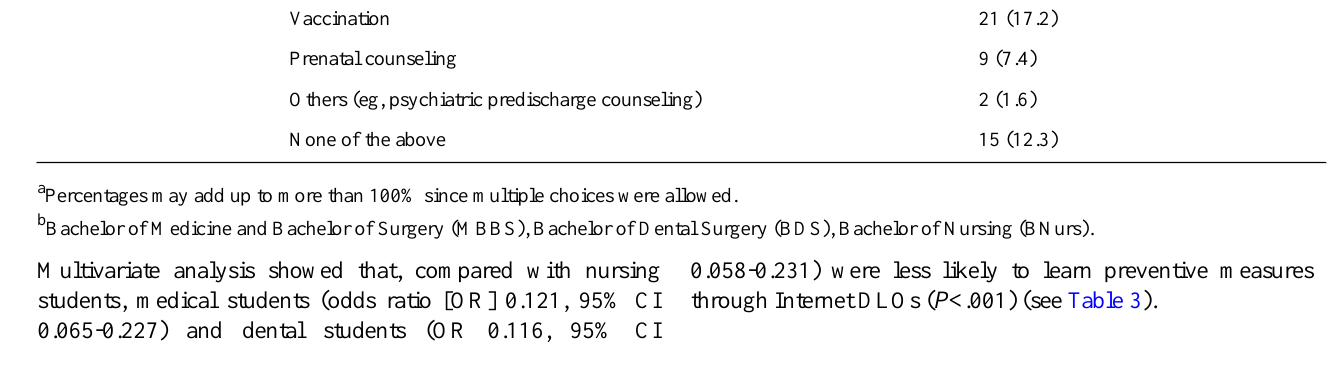
Table 3. Effect of program on learning of preventive measures.